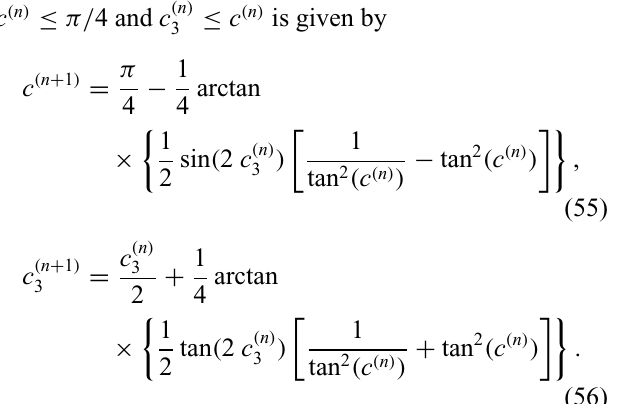
) ≈ sin ( 2 c ( ∞ ) ) , 3 3 ) 3 = 0, in the base of 3 ∈ ( 0, π/ 4] converge to 3